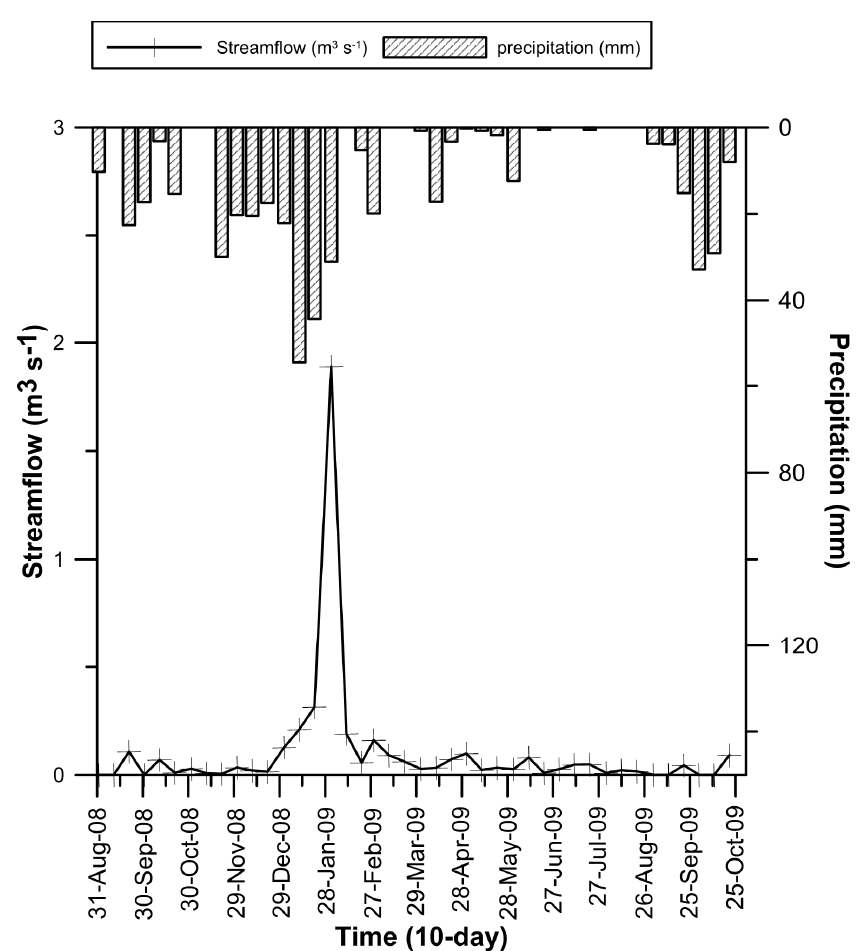
Figure 2. Rainfall (mm) and streamflow (m 3 ∙ s − 1 ) data in the Chaminé stream in the Roxo catchment.